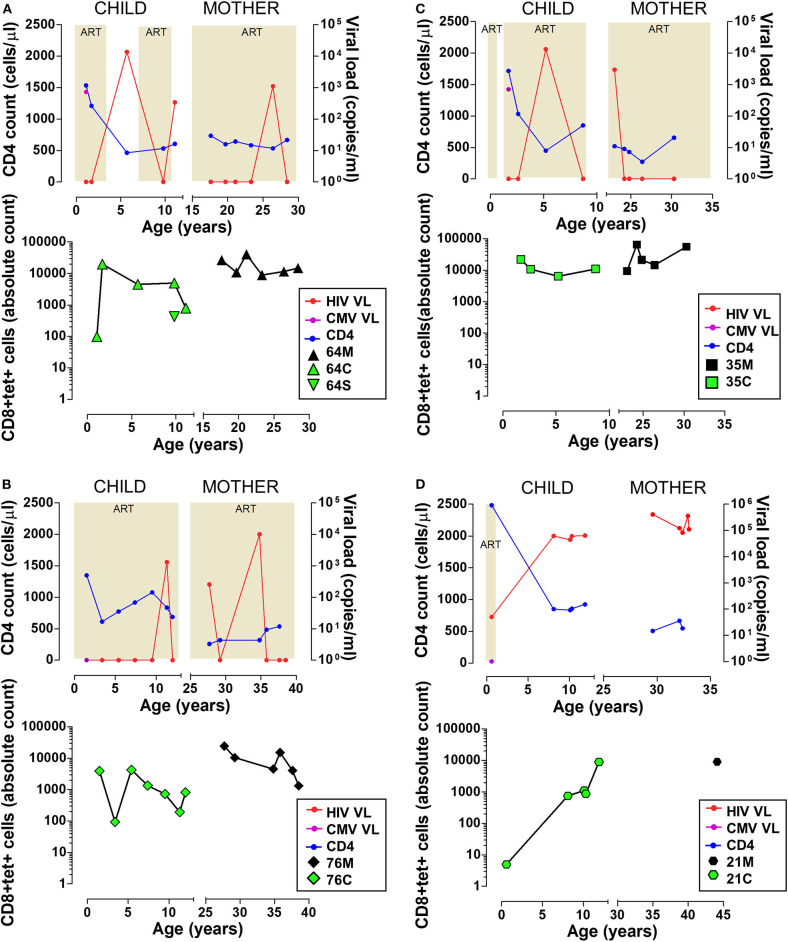
High magnitude HLA-B*44:03-restricted, NW8-specific T cell responses are detectable over 12+ years in four mother-child pairs. Clinical data and frequency of tet+ CD8 T cells are shown for four mother-child pairs. (A) 64C and 64M, as well as 64S, an HIV-uninfected sibling of 64C. (B) 76C and 76M. (C) 35C and 35M. (D) 21C and 21M. For 21M, only one timepoint was sampled and clinical data was not available. In all panels, data from the child is displayed on the left and data from the mother on the right side. Clinical data (top) includes the CD4 count in blue, HIV viral load in red, and CMV viral load in purple. The shaded areas indicate the periods when the subjects were on antiretroviral therapy. Longitudinal tetramer data (bottom) is shown as green symbols for children, and black symbols for mothers.